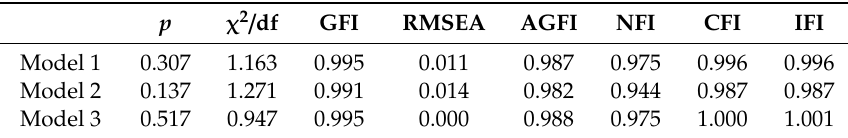
Table 4. Model fitting index.